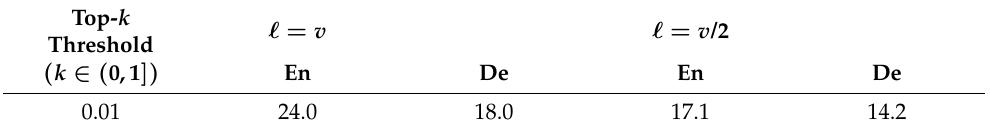
Table 6. Depth of label assignment for large corpus.